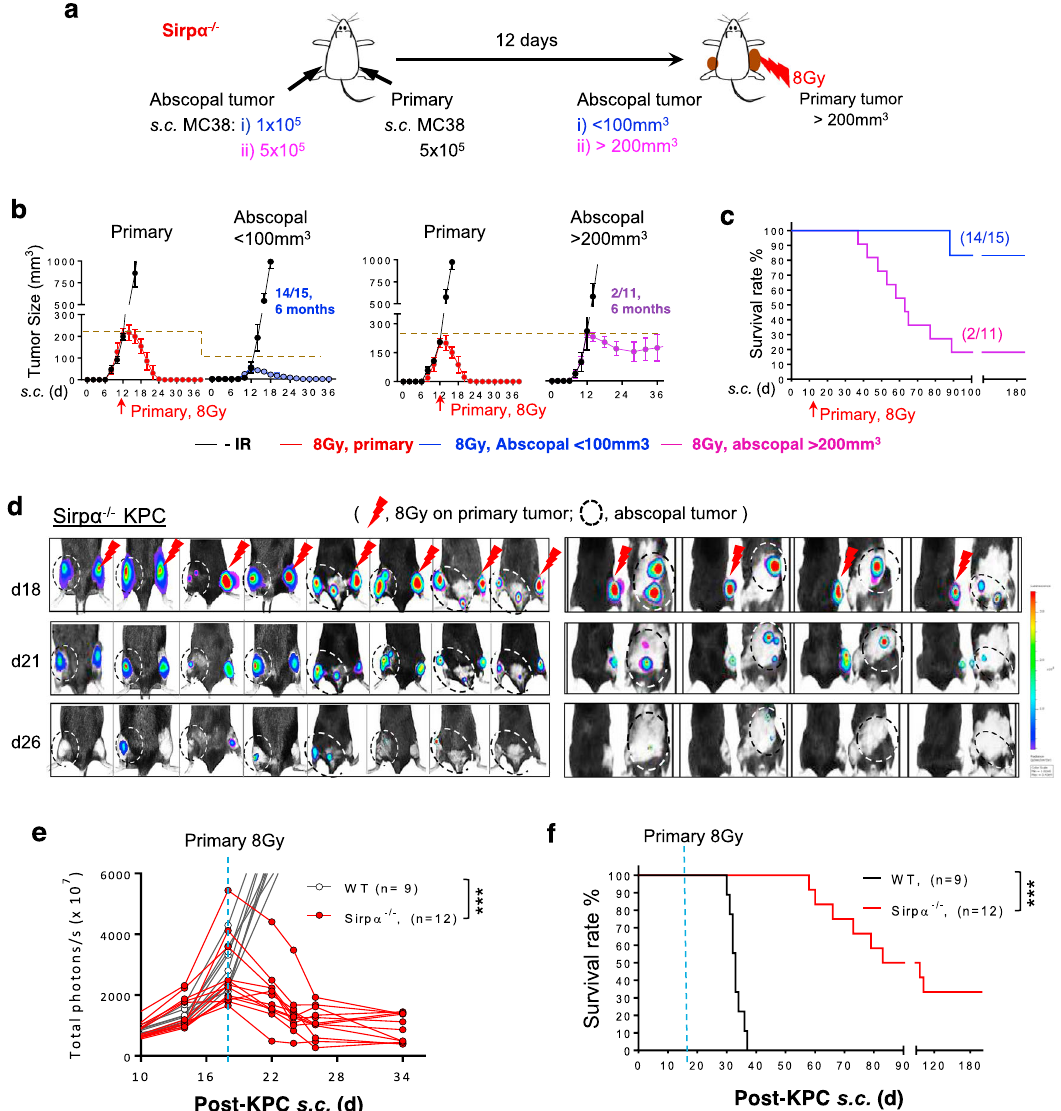
Fig. 7 Sirp α − / − mice exhibit RT-induced abscopal effects and long-lasting anti-tumor immunity. a – c MC38 tumors were simultaneously engrafted in the right fl ank (5 × 10 5 , primary) and left fl ank (1 – 5 × 10 5 , abscopal) in Sirp α − / − mice. The primary tumor on the right fl ank was irradiated with 1 × 8 Gy on day 12 post tumor engraftment when the volume of abscopal tumors was <100 mm 3 or >200 mm 3 ( a ). Tumor volume ( b ) and animal survival ( c ) were recorded. Data from three independent experiments (3 – 5 mice/group in each experiment) are presented as mean ± SEM. n = 15 mice (abscopal< 100 mm 3 ) and 11 mice (abscopal > 200 mm 3 ). d – f Luciferase-expressing KPC tumors were simultaneously engrafted in the right fl ank (primary) and other locations including left fl ank, dorsal or peritoneal cavities in WT and Sirp α − / − mice, followed by irradiation on the primary tumor once its volume